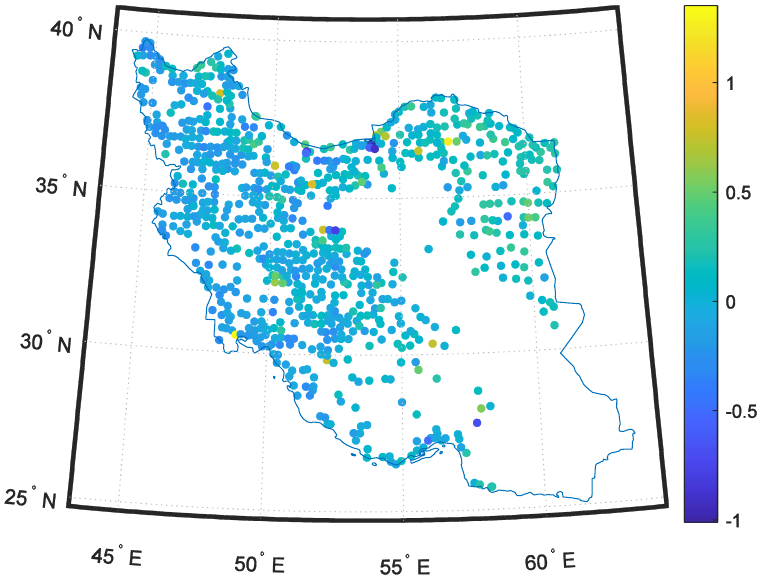
Figure 5 . RMS of the XGM2019e_2159model in 841 GPS/Levelling points up to the degree of 2190.